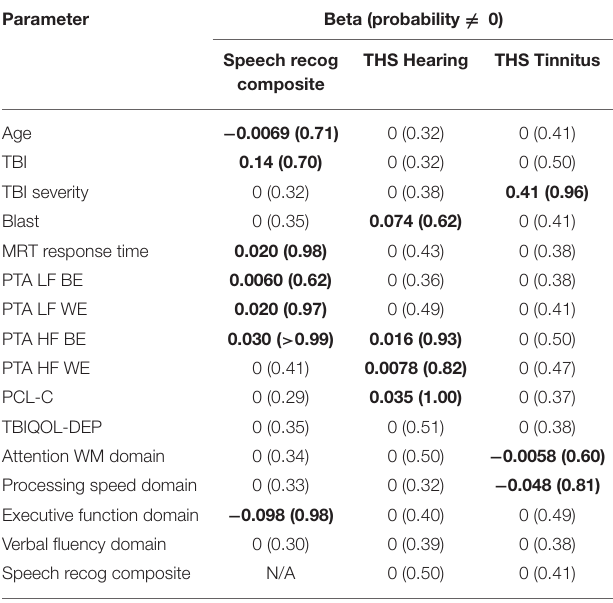
TABLE 1 | Results of Bayesian LASSO regressions.